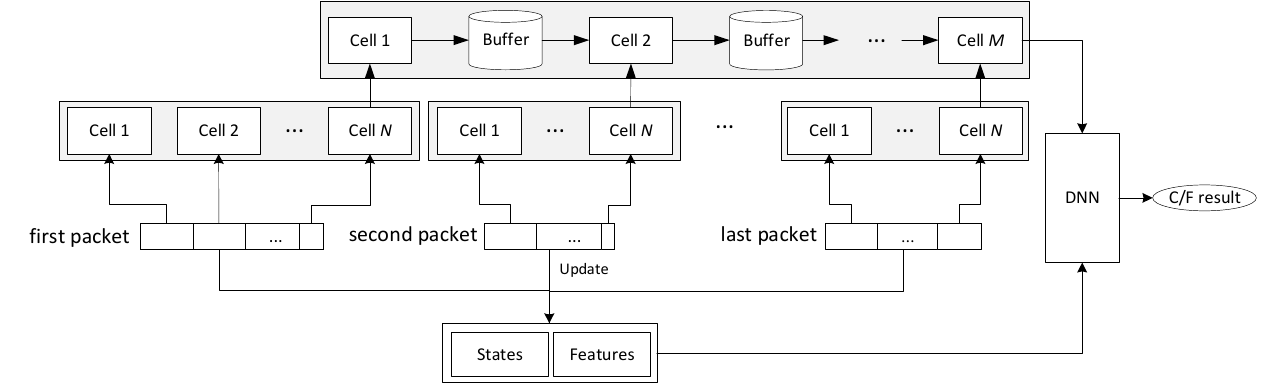
Figure 3. Proposed system architecture composed of two-stage LSTM and DNN.